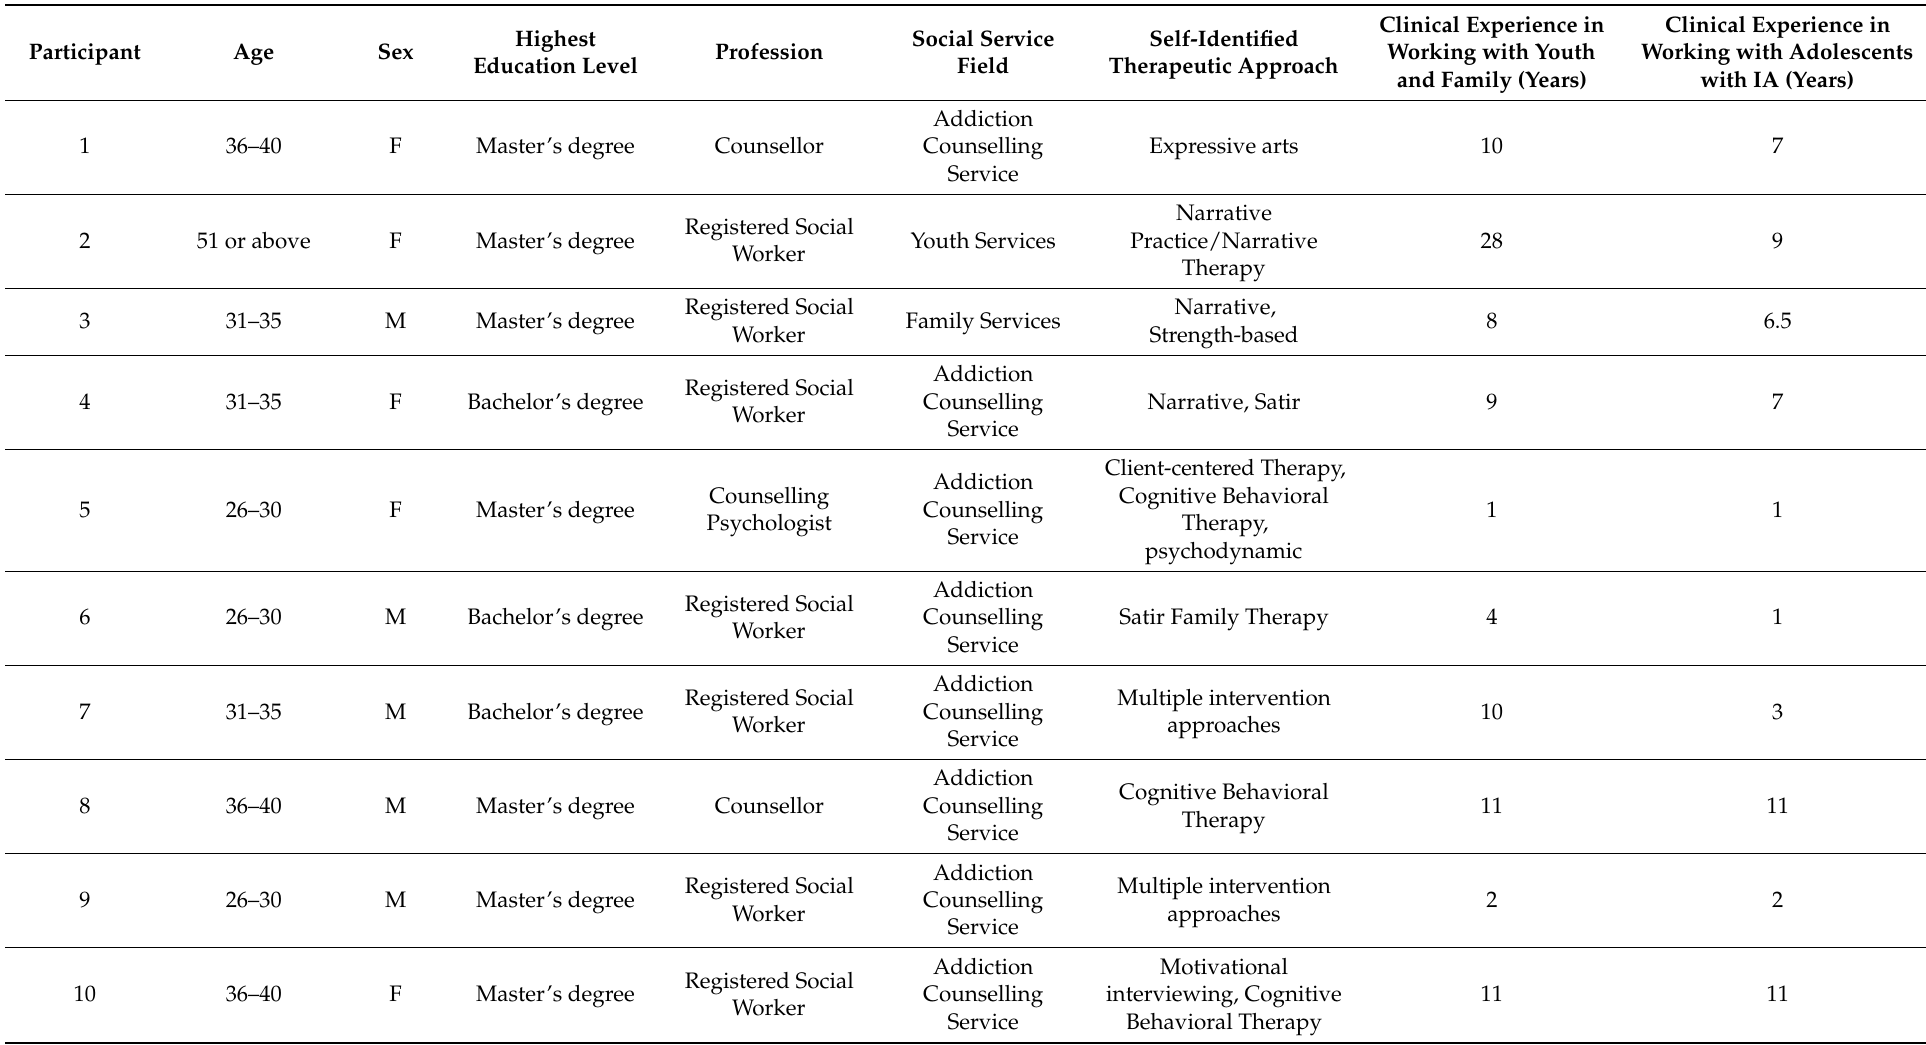
Table 2. Demographic information of the